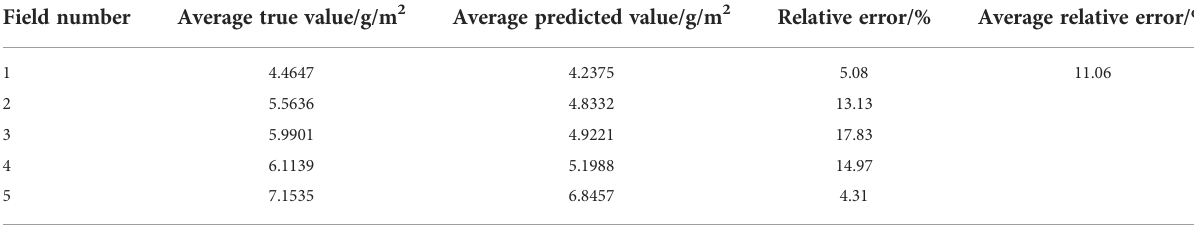
TABLE 3 Comparison of the prediction results regarding the residual fi lm content in the plough layer. Field